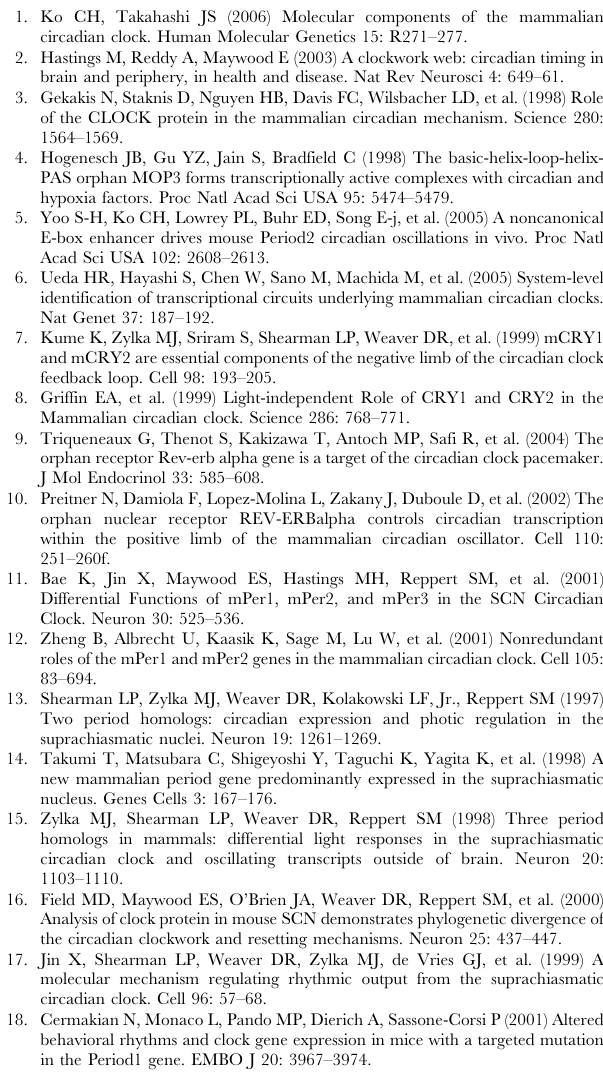
Figure S1 Analysis of the effect of PER1/2 negative feedback regulation on expression period and phase.